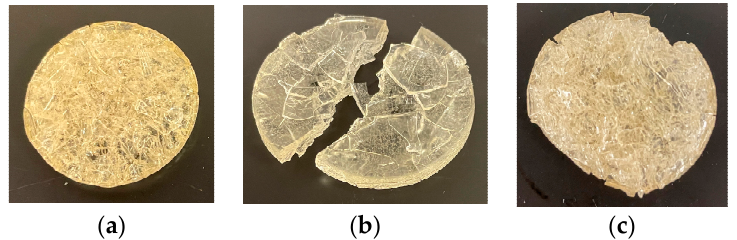
Figure 11. Chemically crosslinked gels tested from pulsatile swelling studies: ( a ) Dried FC34 after three cycles; ( b ) broken FC36 at 192 hrs; and ( c ) dried, partially broken FC37 after three cycles.